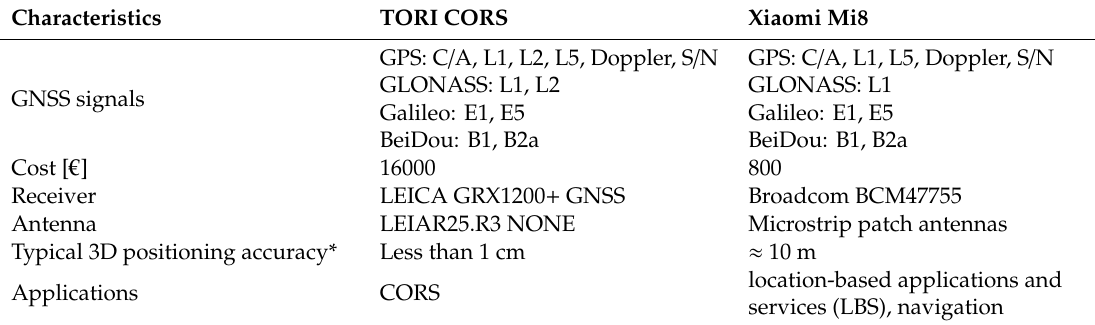
Table 1. GNSS receivers used as master stations. *accuracy provided for illustrative purposes [14,18].